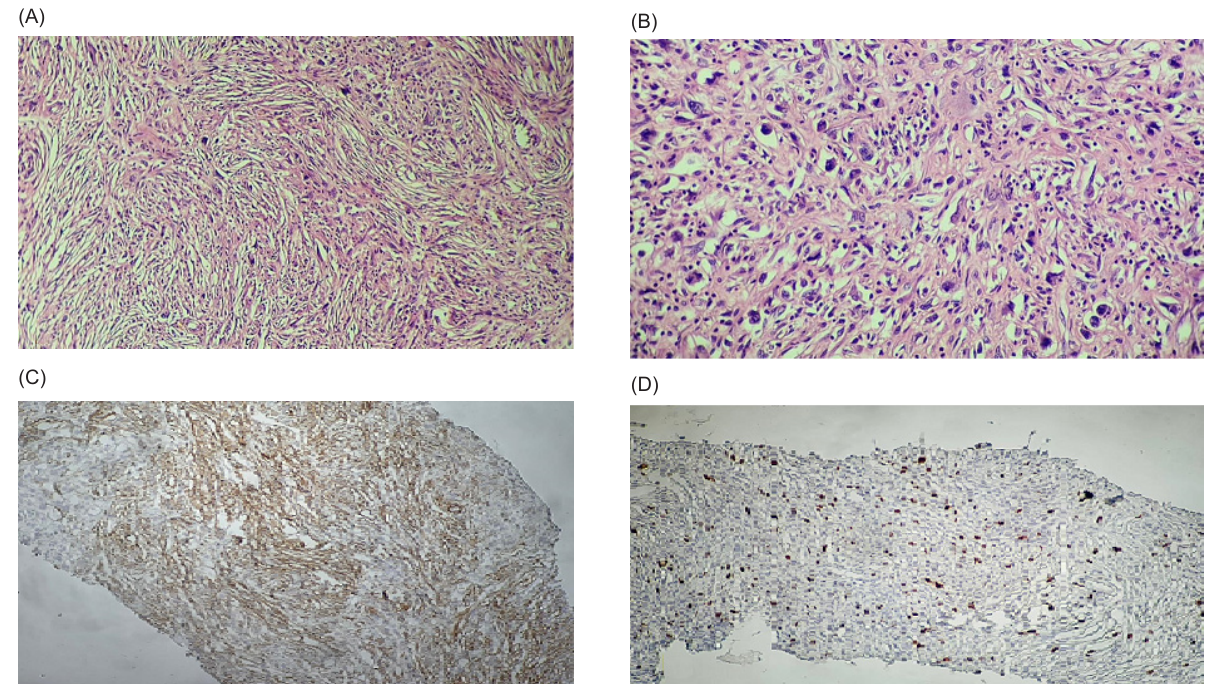
FIGURE 2: (A) Short fascicles of spindled myofibroblastic cells without overt atypia admixed with acute and chronic inflamma- tory cells (200×). (B) Ganglion-like polygonal cells with large rounded nuclei and prominent nucleoli (400×). Immunohistochem- istry (IHC) analyses revealed positive reaction for (C) smooth muscle actin (SMA) and (D) Ki-67